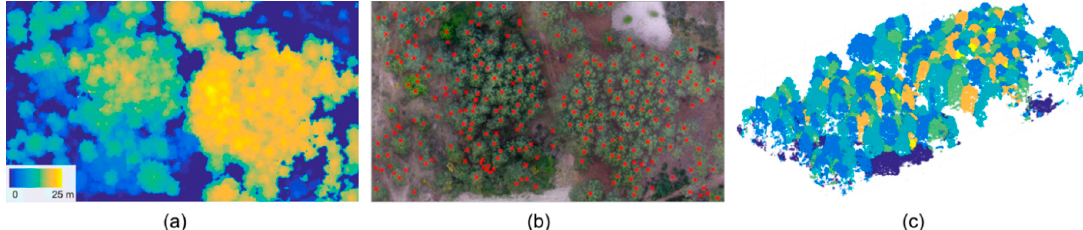
Figure 2. Example of an individual tree crown detection and delineation approach using: ( a ) a canopy height model; ( b ) identified treetops using local maxima; and ( c ) tree crown delineation using watershed transform.